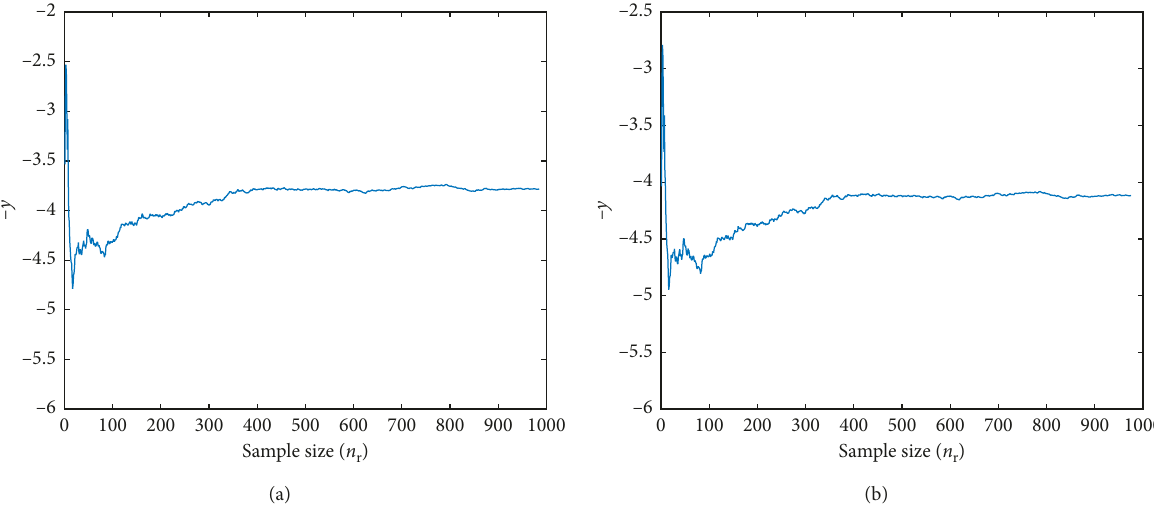
β . (a) Case 1. (b) Case 2. r for the estimation of (cid:31)